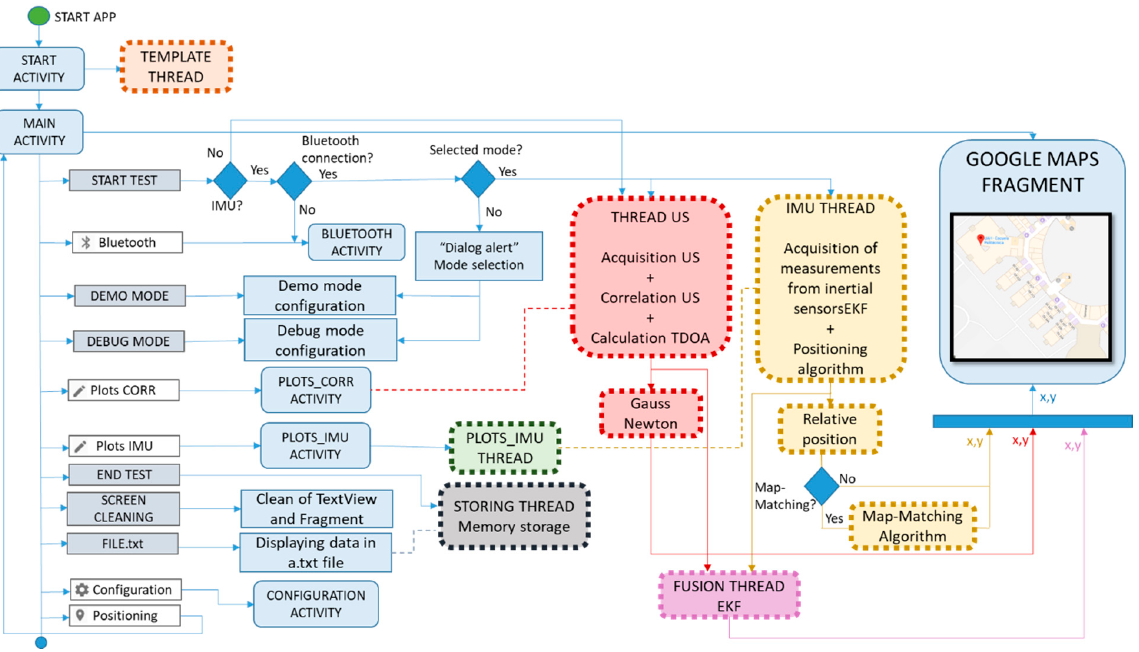
Figure 12. LOCATE-US Application flowchart.